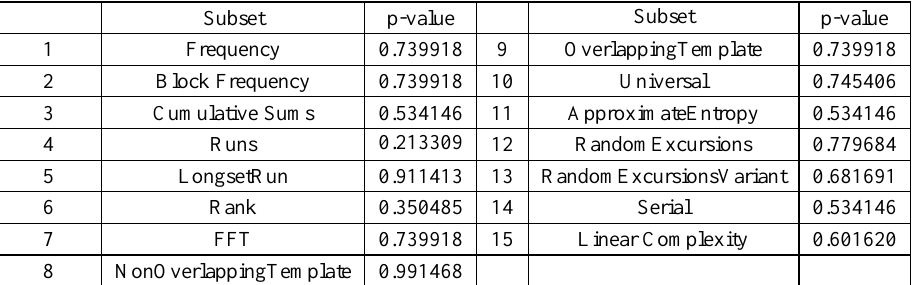
Table 2. Test result of random